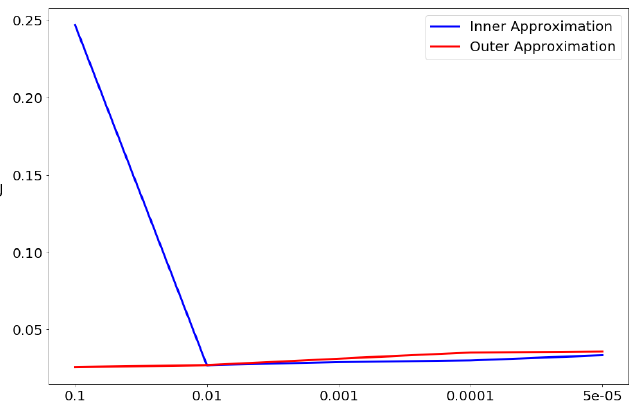
Figure 9. Optimal functional values of the inner and outer problems for decreasing values of τ .